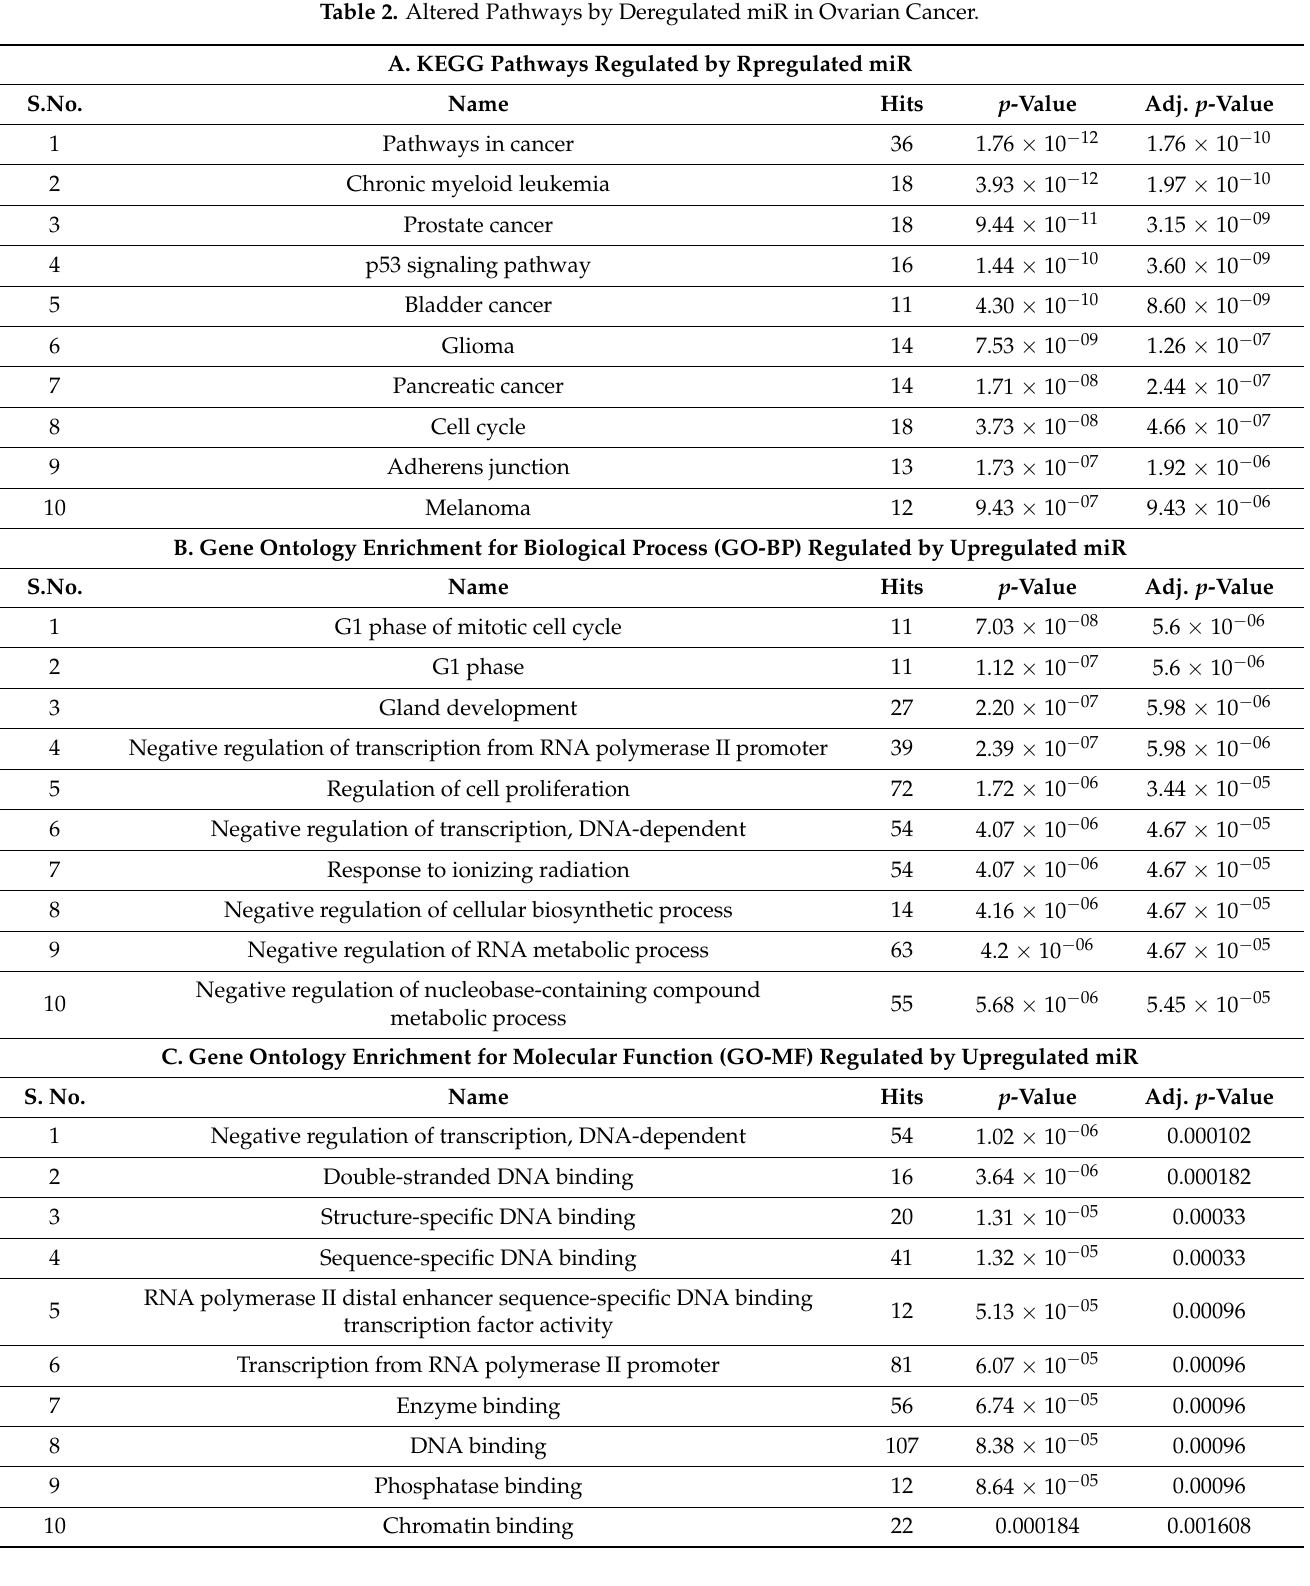
Table 2. Altered Pathways by Deregulated miR in Ovarian